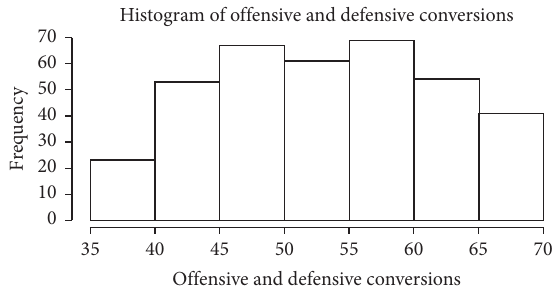
Figure 8: Distribution histogram of offensive and defensive conversions in 368 games. Table 4: Huskies substitution in Match 6.